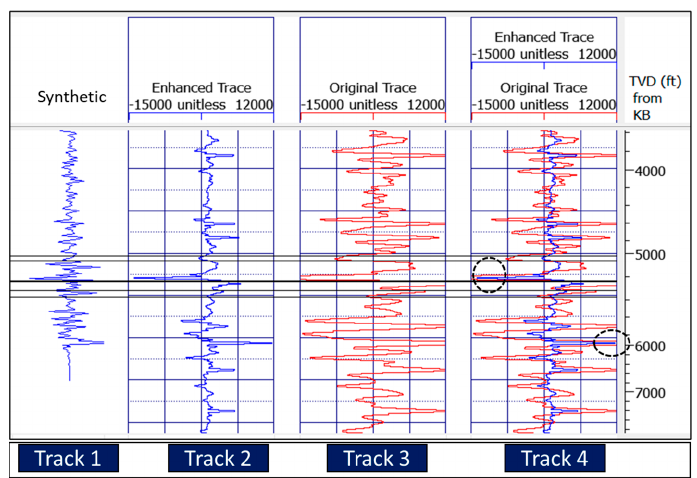
Figure 18. Comparison of the original (Track 3) and enhanced (Track 2) traces to the synthetic seis- mogram (Track 1). Track 3 shows an overlay of both traces. The horizontal black lines are the for- mation (correlation) tops across the synthetic and traces, and they match the seismic traces in time.